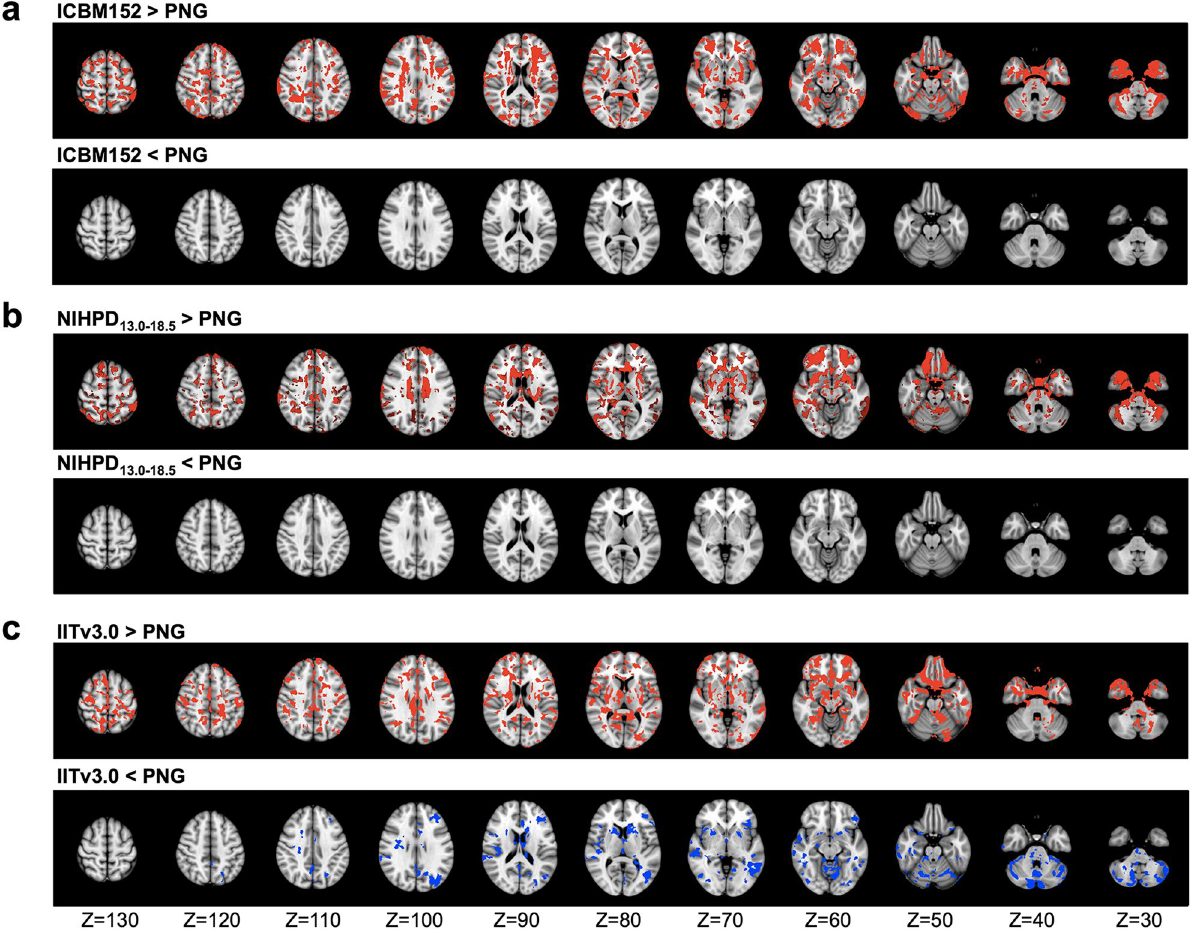
NIHPD 13.0–18.5 21 , and ( c ) IITv3.0 11 , represented in axial view in ICBM152 space. Red/blue indicates significantly